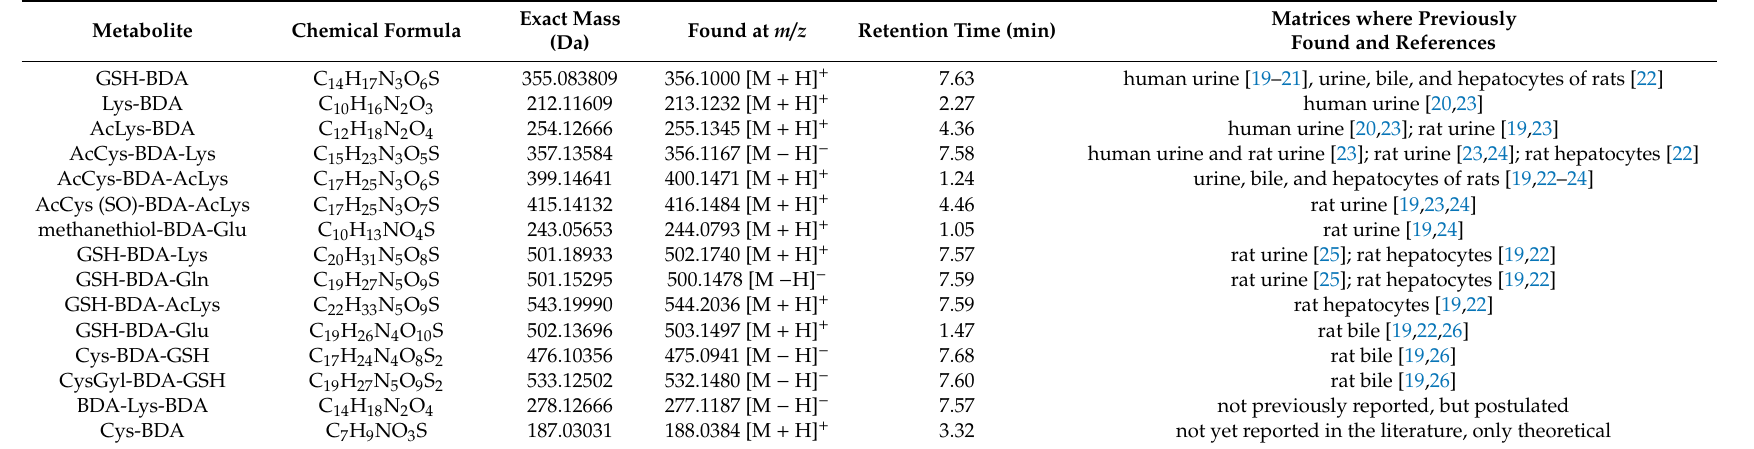
Table 1. Exact mass, found mass, and retention time of each furan and 2-methylfuran metabolite identified by UPLC-qToF-MS / MS, and matrices in which they have been previously found (with supporting references). Meanings of the abbreviated metabolites’ names are given in the text or present the meanings in a footnote.